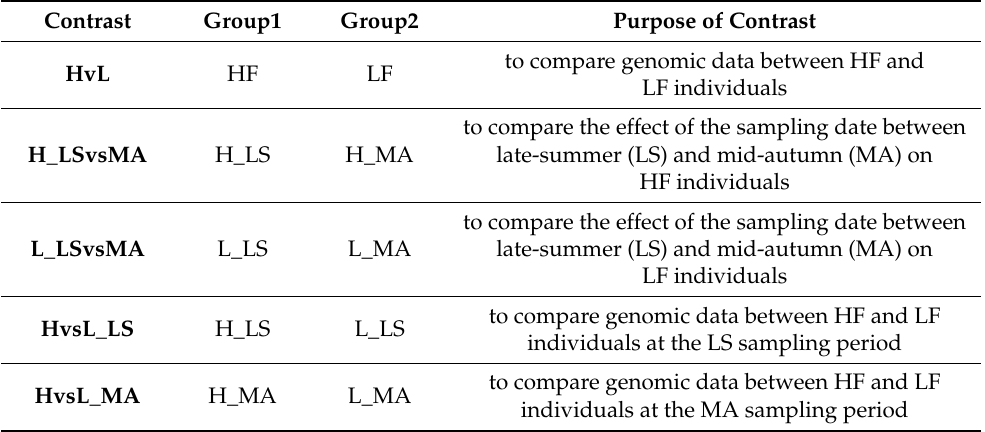
Table 1. Five distinct contrasts used through a linear model to compare the phenotypic breeding boar